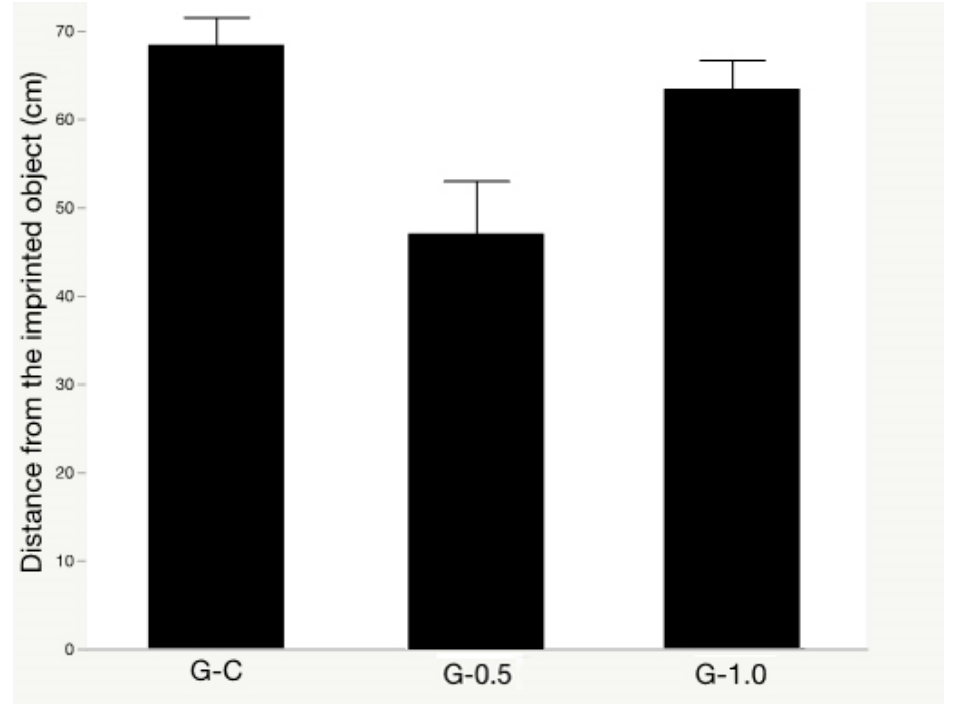
Figure 3. The synbiotic effects on object memory test of broilers exposed to acute heat stress. Treatments: a regular diet supplemented with 0 (G-C), 0.5 (G-0.5), and 1 (G-1.0) g kg − 1 synbiotic, respectively. Data presented as means ± SE ( n = 8, 16 birds/treatment).